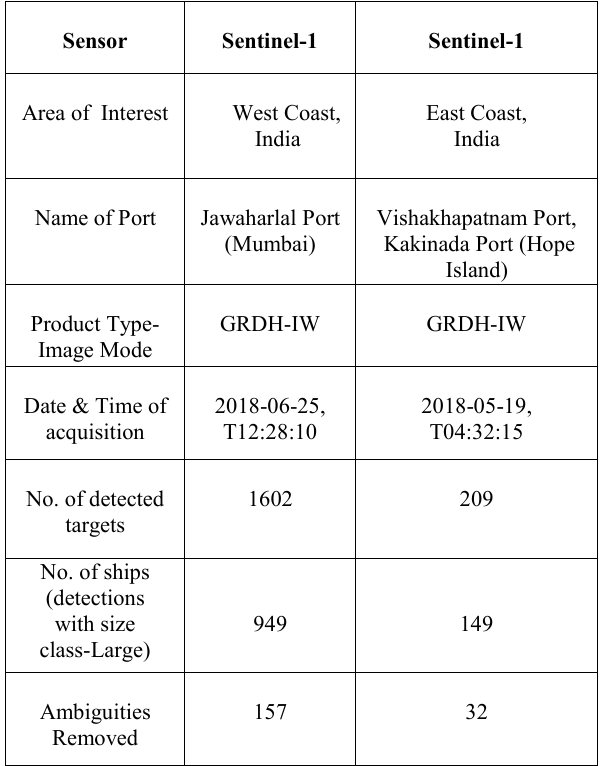
Table-1. SUMO Detection